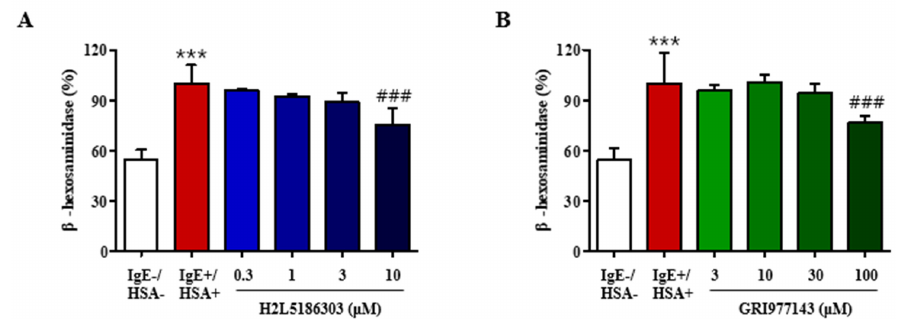
Figure 1. H2L5186303 inhibits antigen-induced degranulation in RBL-2H3 mast cells. After sensitization with anti- dinitrophenyl immunoglobulin E (DNP-IgE) for 18 h, RBL-2H3 cells were challenged with dinitrophenyl-human serum albumin (DNP-HSA). H2L5186303 ( A ) and GRI977143 ( B ) treatment was performed at the indicated concentrations 30 min before antigen challenge. Basal degranulation shows samples without IgE and HSA, and the positive control shows samples with IgE and HSA. The results are presented as the mean ± standard error (SE) of three independent experiments. *** p < 0.001 vs. the HSA ‐ untreated group. ### p < 0.001 vs. the HSA ‐ treated group.